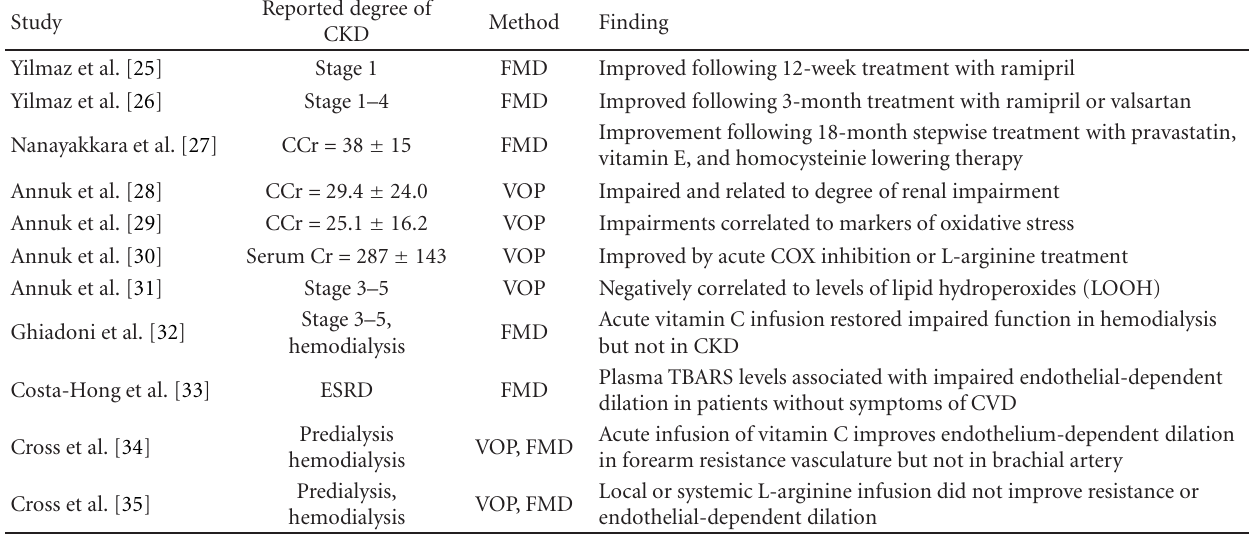
Table 2: Summary of studies measuring in vivo endothelial function in adult patients with CKD.